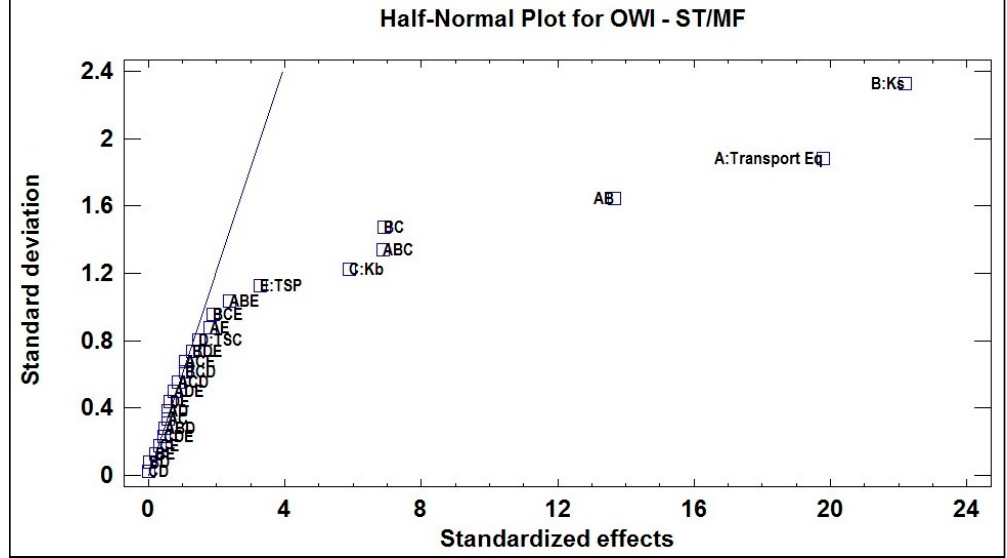
Figure 4. Normal Probability of Effects for the weighted indicator of sedimentological and Figure4. NormalProbabilityofE ff ectsfortheweightedindicatorofsedimentologicalandmorphological morphological adjustment (OWI ST, MF ) in experimental design 2 k . adjustment (OWI ST, MF ) in experimental design 2 k . Table 5 . Analysis of Variance (ANOVA) results for the 2 k experiment.